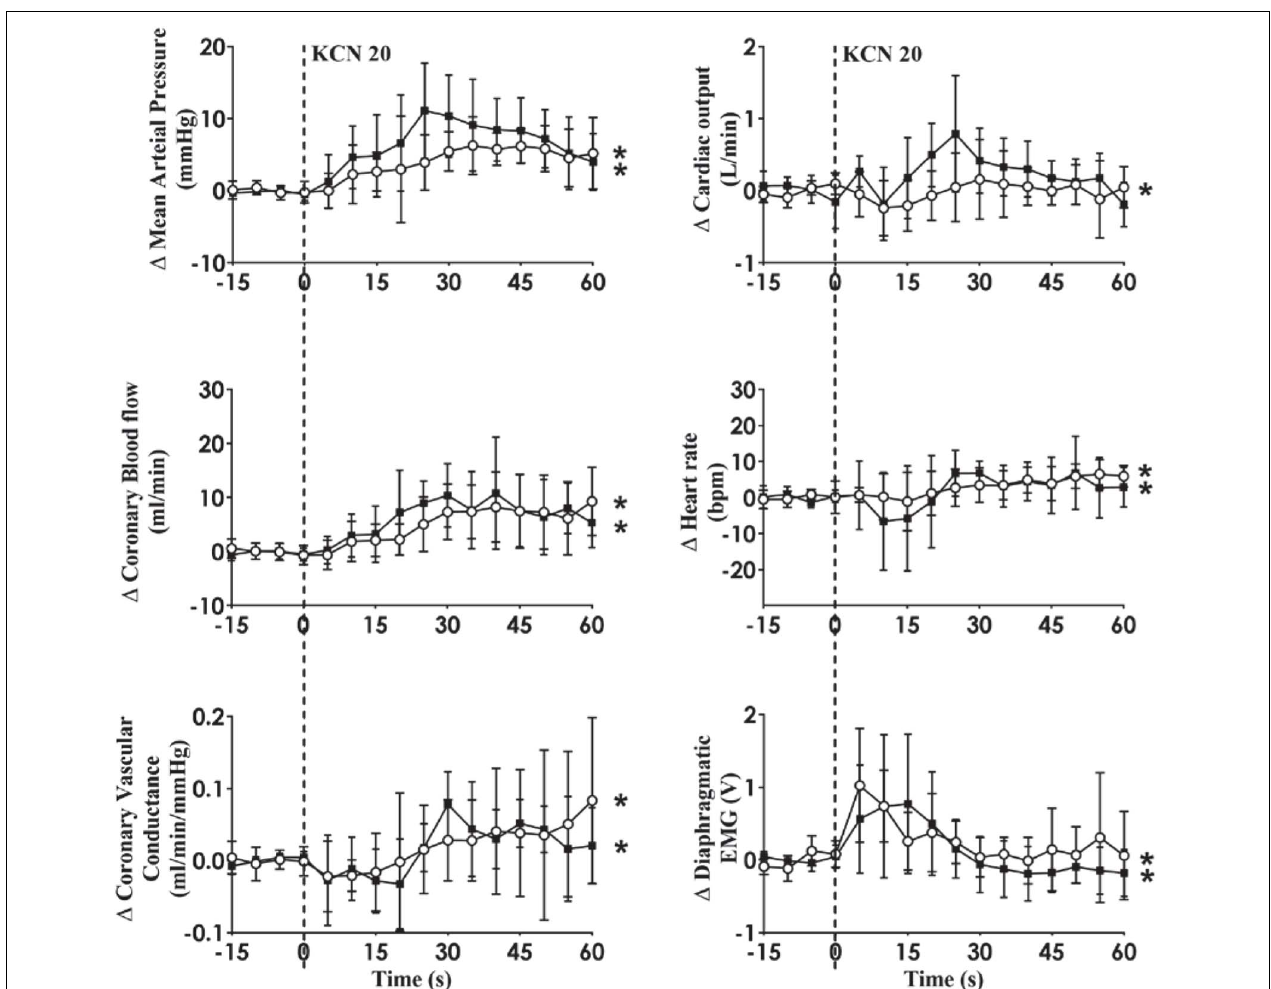
FIGURE 3 | Effect of carotid body activation on breathing and hemodynamic responses in control ( n = 6) and heart failure (HF; n = 6) sheep. Absolute change in mean arterial pressure, coronary blood flow, coronary vascular conductance, cardiac output, heart rate, and dEMG in response to intra-carotid potassium cyanide (KCN; 20 mg/kg) injection in control (open circles and solid line) and heart failure (filled squares and solid line) sheep. Results are mean SD. * p < 0.05 denotes a significant effect of time (ANOVA, *effect within 1 min time after